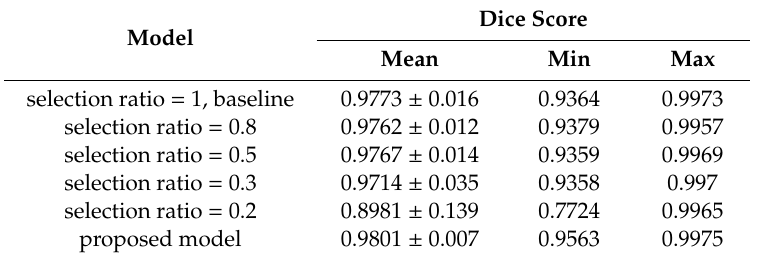
Table A2. Spleen segmentation results on test dataset based on di ff erent selection ratio using FCN model.